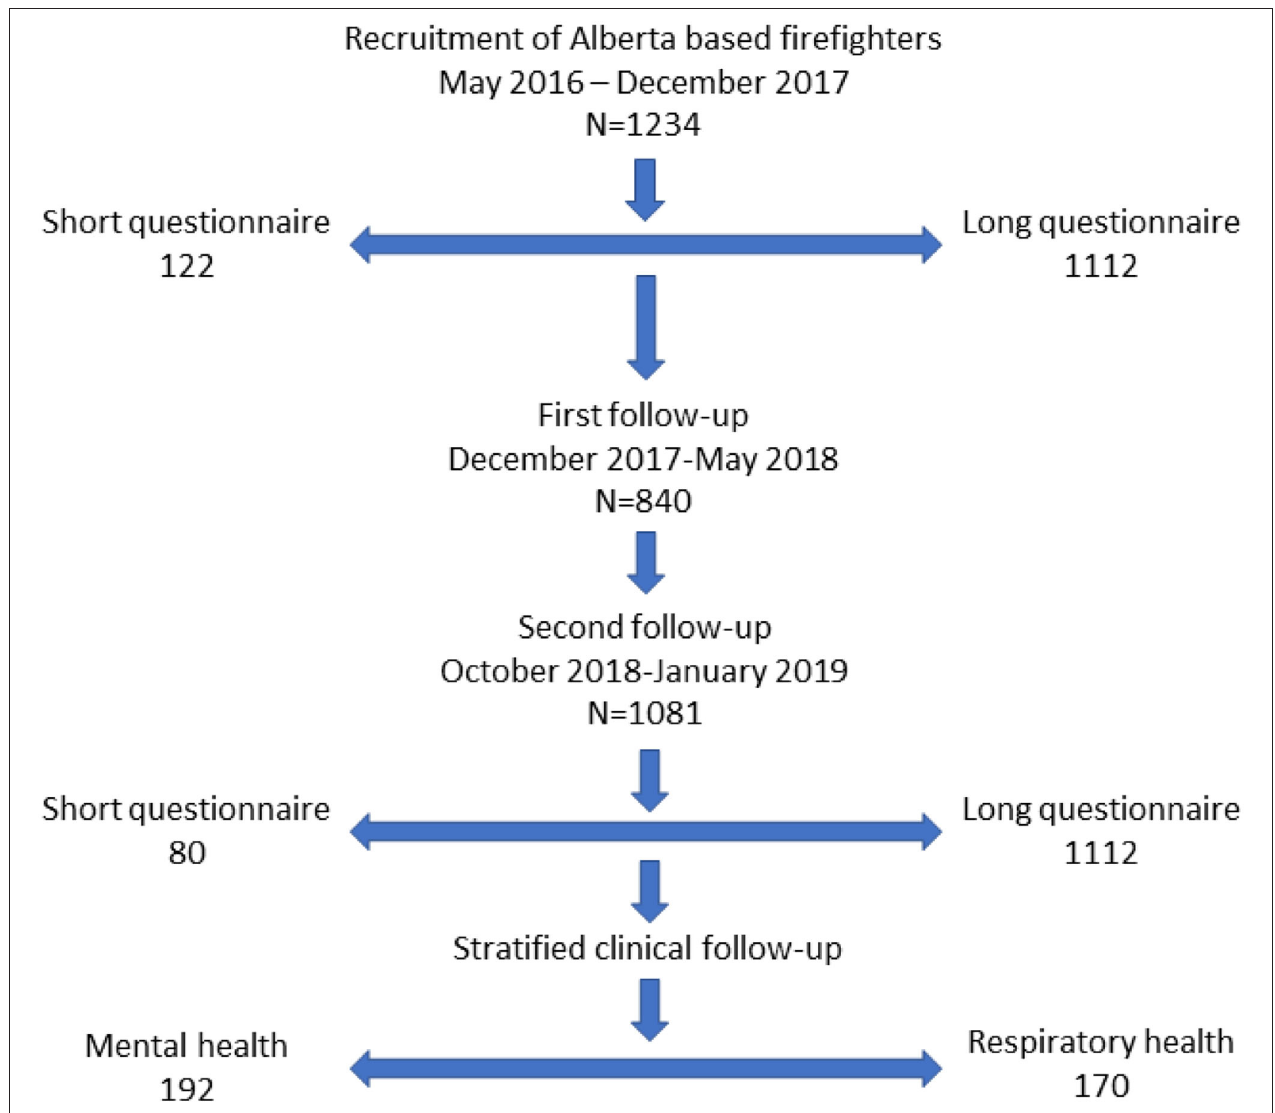
FIGURE 1 | Response of firefighters at each